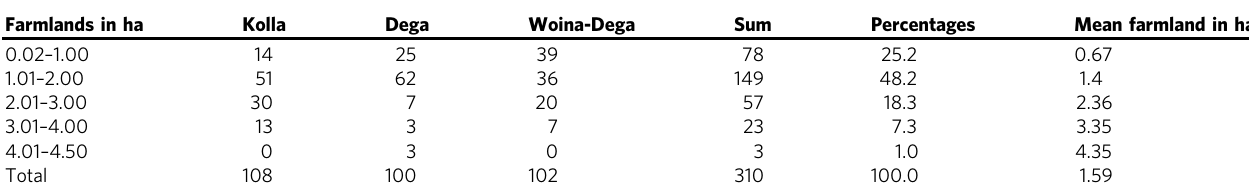
Table 4 Households farmland access by agro-zones. Farmlands in